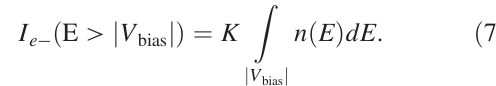
FIG. 9. Normalized energy spectrum of electrons n ð E Þ (blue open circle) recorded by the EKD electrode in station 4 during a fill at 6500 GeV (data with courtesy of Elena Buratin). Lines are fit to experimental data with Eq. (6): total spectrum (blue line), low energy part (red line), and high energy part (green line).